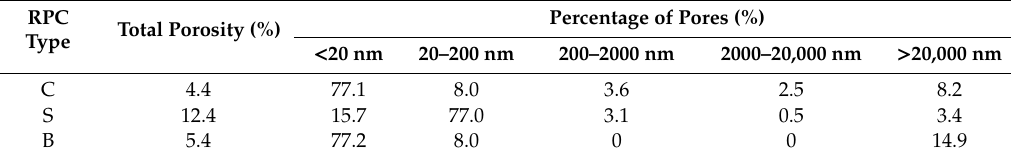
Table 7. RPC concrete total porosity and percentage of di ff erent sized